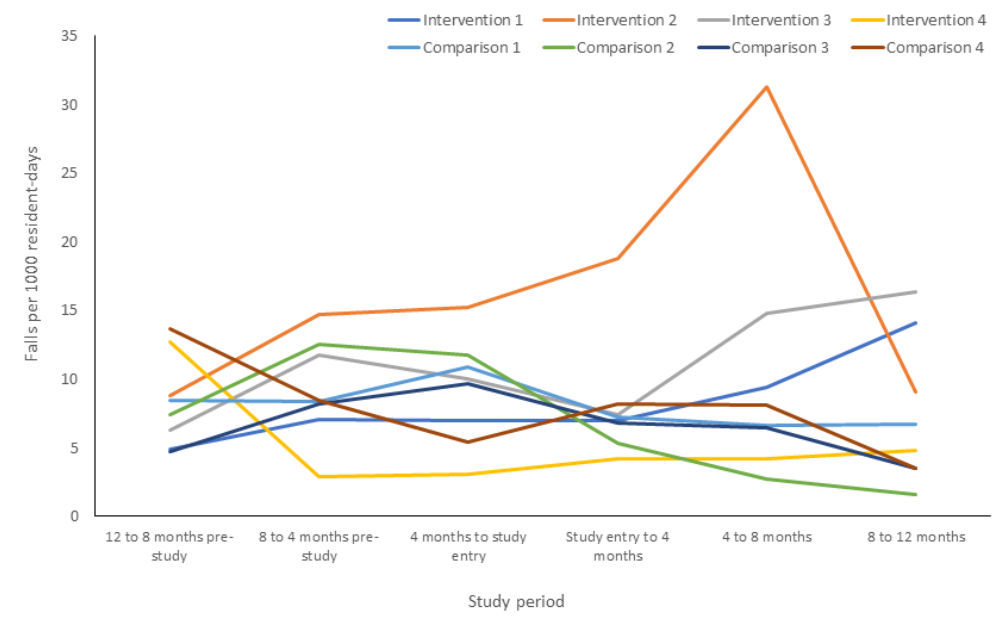
Figure 4. Falls per 1000 resident days in the 12 months before and after study entry, stratified by facility.